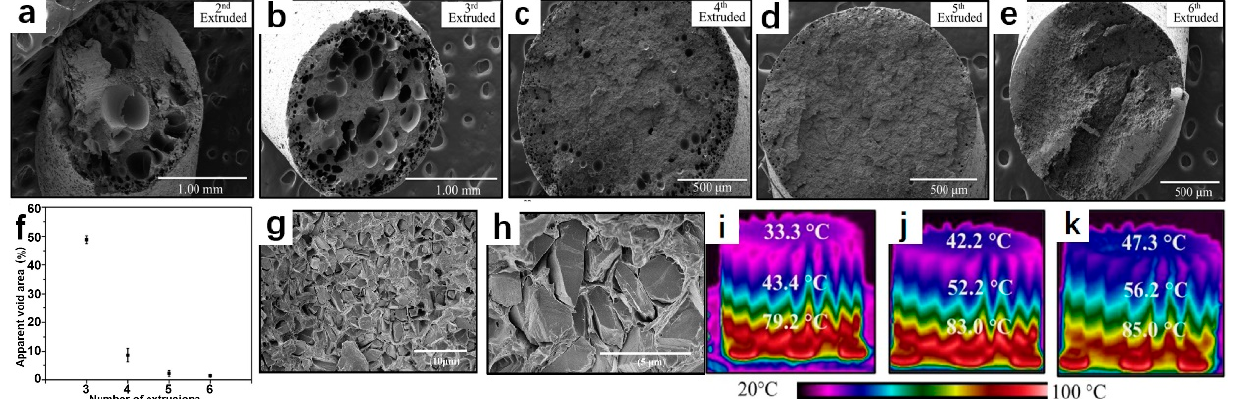
Figure 14. ( a – e ) SEM images of diamond/ABS filament cross section after 2–6 extrusions; ( f ) its apparent void area; ( g , h ) SEM images of diamond/ABS (60%) showing that the diamond is only physically connected to the polymer; ( i – k ) temperature distribution of 3D-printed heat sinks made of ABS, D-ABS (37.5%), D-ABS (60%) after heating for ten minutes (reproduced with permission from Reference [105], Copyright 2019 American Chemical Society).